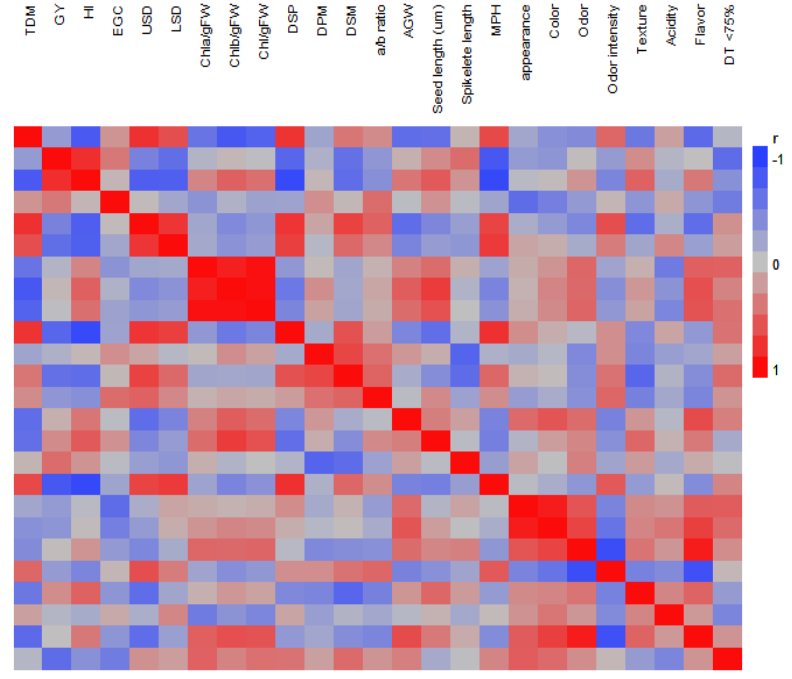
Figure 4. Heat map of Coe ffi cients of correlation (r) for the measured